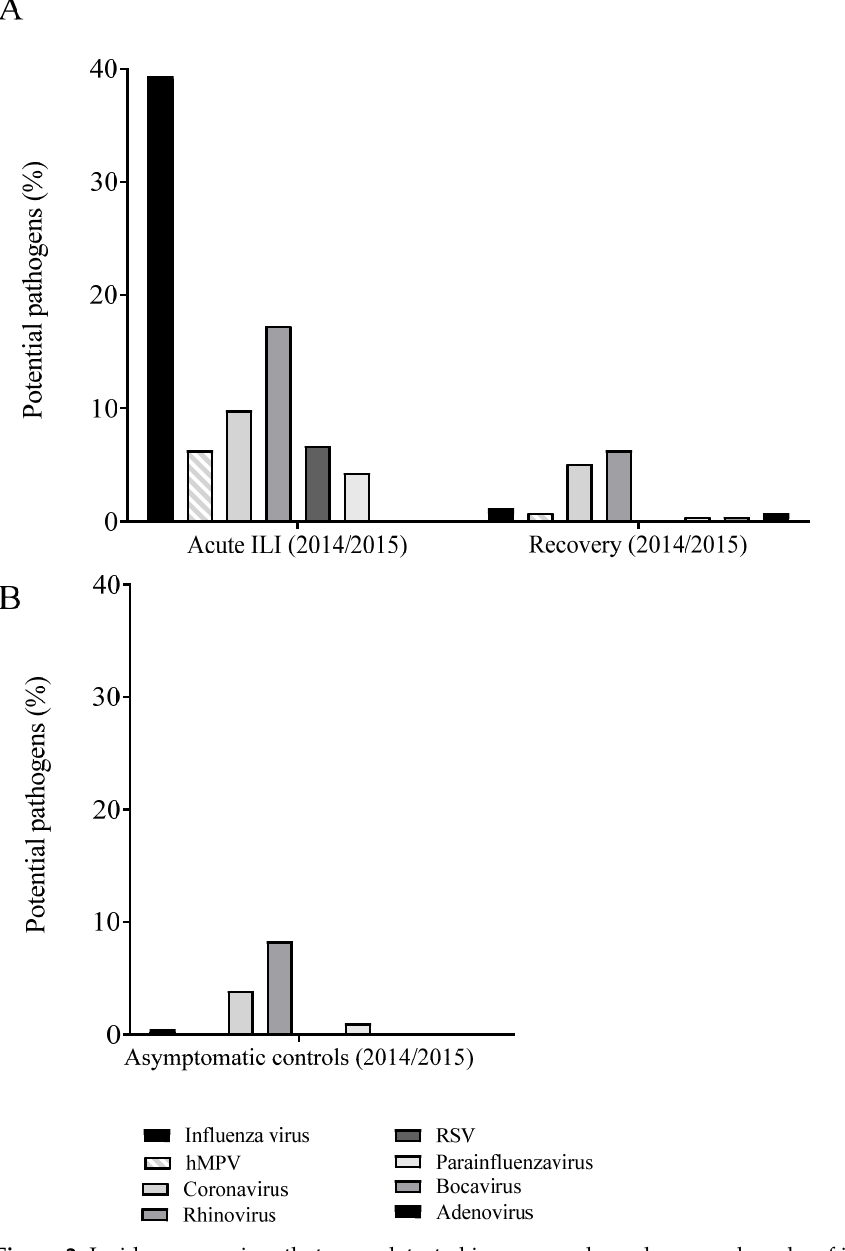
Figure 2. Incidence per virus that were detected in naso- and oropharyngeal swabs of influenza-like illness (ILI) cases in the acute phase (left panel) and at recovery (i.e., 8 weeks later) (right panel) ( A ) and of first samples of asymptomatic controls, i.e., participants aged ≥ 60 years, and without ILI symptoms ( B ) in influenza season 2014–2015. The percentages were calculated per ILI event. Multiple pathogens could be detected in a single event and therefore contribute to the incidence for multiple pathogens. Abbreviations: hMPV, human metapneumovirus; ILI, influenza-like illness; RSV, respiratory syncytial virus.